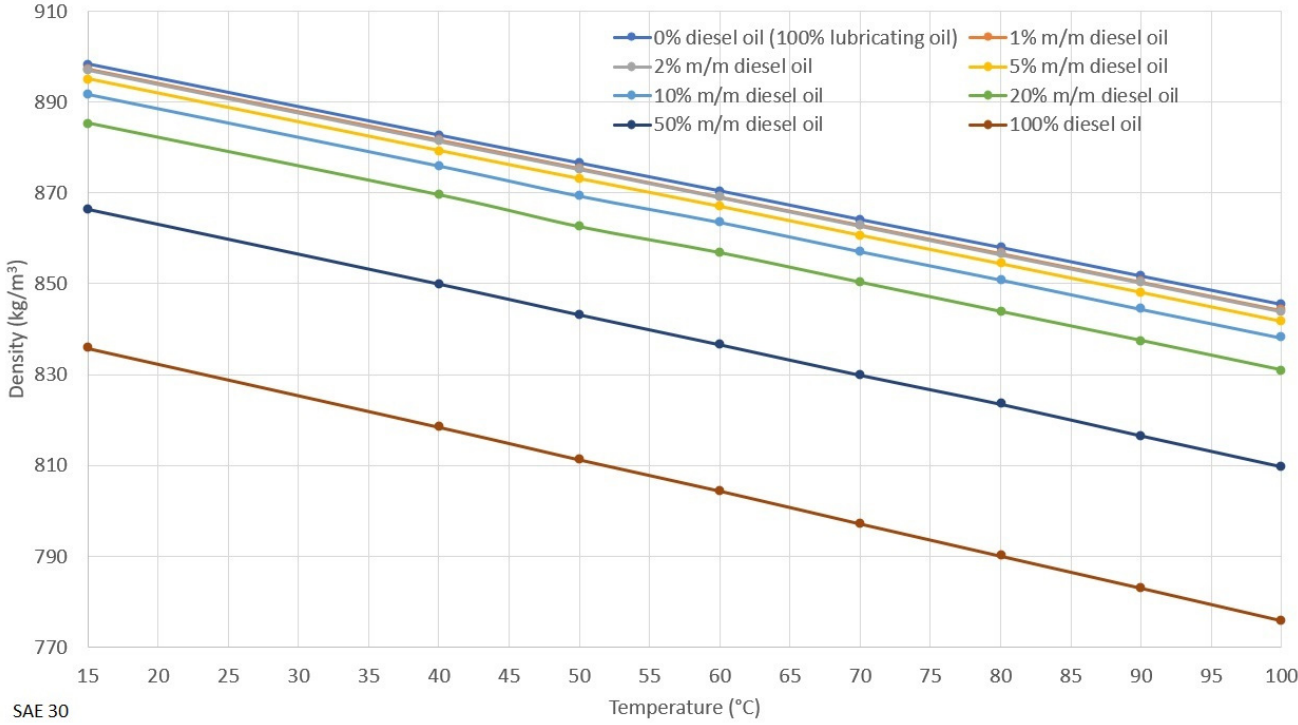
Figure 11. Measured values of SAE 30 class oil density in the temperature range of 15–100 °C at different levels of lubricating oil dilution with diesel fuel.